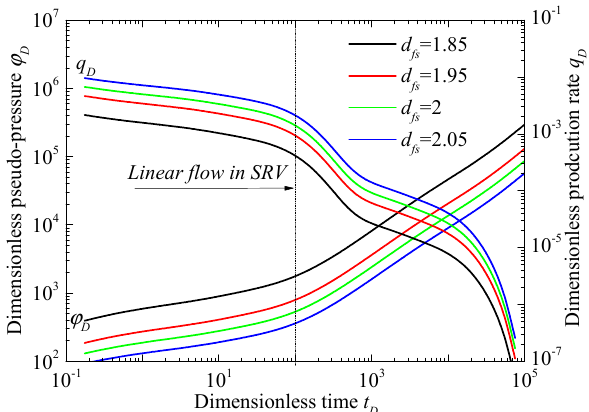
Figure 6. Comparison of production rate and pseudo-pressure with different fractal dimension of induced-fracture spacing d fs by FMFM ( d fa = 2 and θ = − 0.05).